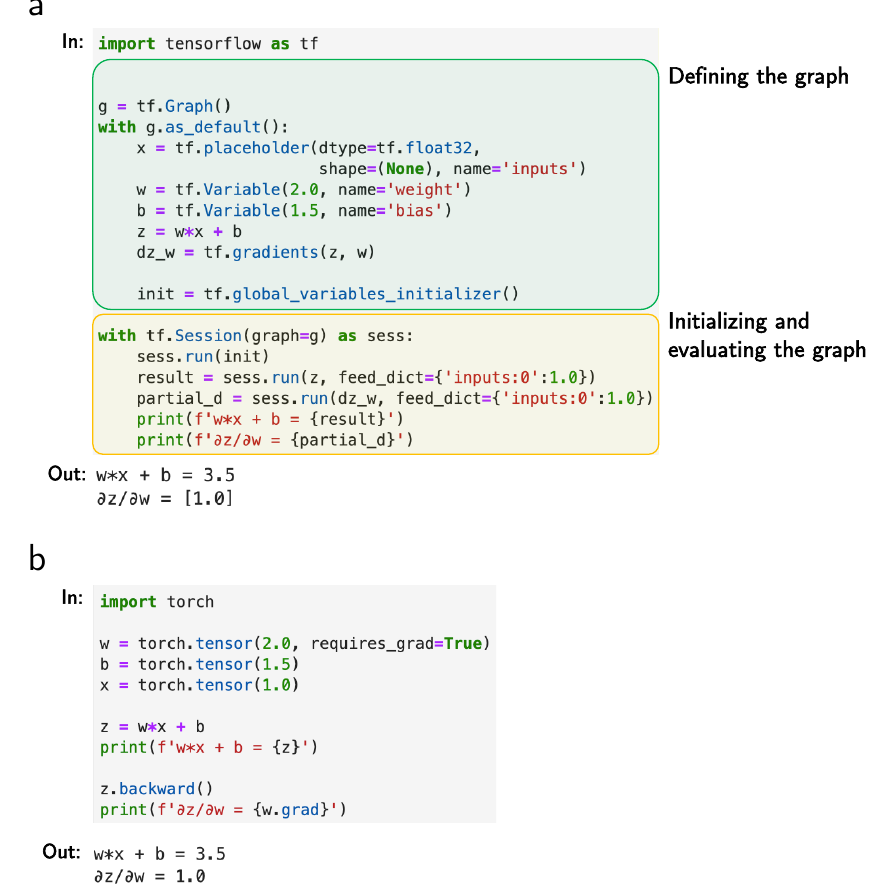
Figure 7. Comparison between ( a ) a static computation graph in TensorFlow 1.15 and ( b ) an imperative programming paradigm enabled by dynamic graphs in PyTorch